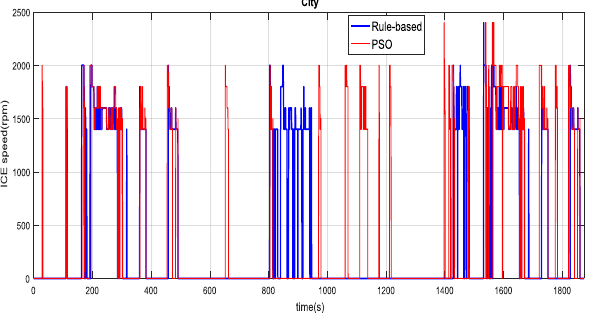
Figure 12. Comparison of engine speed in the urban driving cycle.